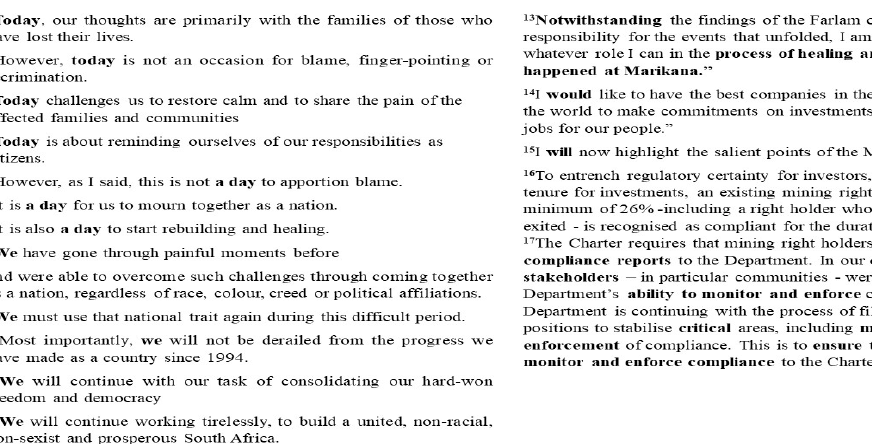
Figure A5. Textual data—analysis of modality. Figure A5: Textual data—analysis of modality. Figure A5: Textual data—analysis of modality.